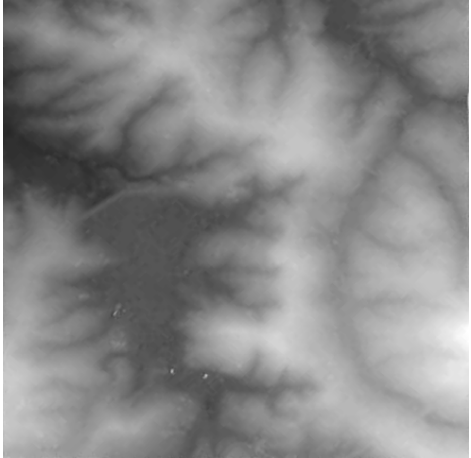
Figure 7. DEM generated from the Interferogram of the Figure 6 interest. The color scale values are in